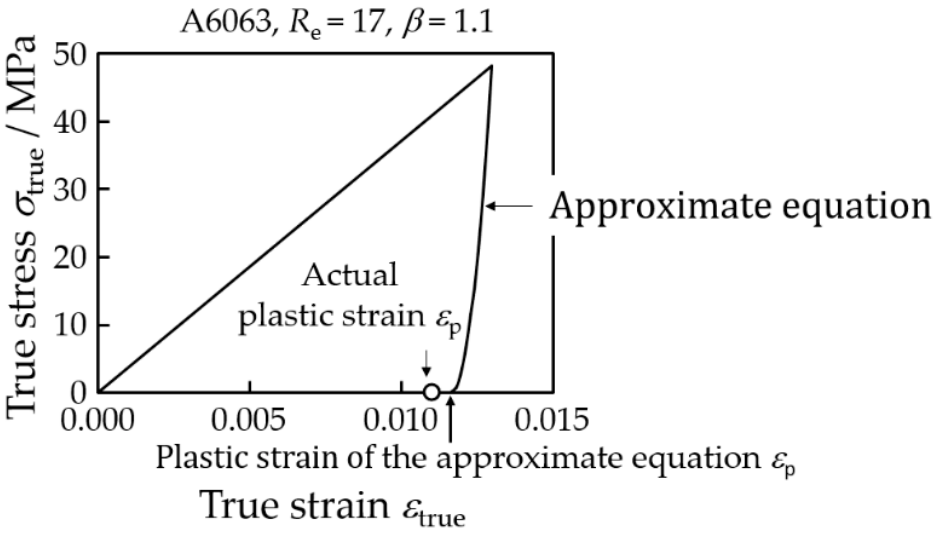
Figure23. Figure 23. Comparison of the actual plastic strain and the value calculated using the approximate equation.